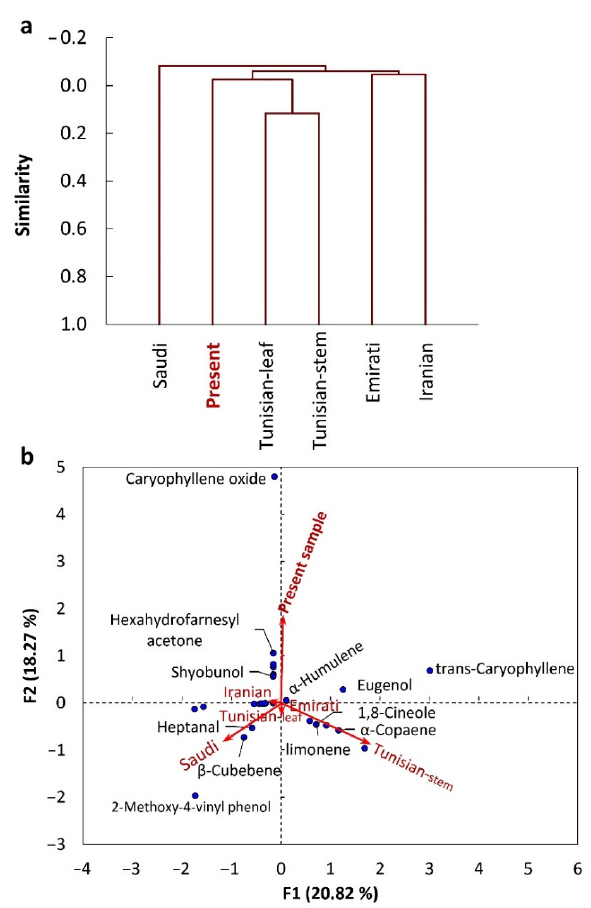
Figure 3. Chemometric analysis of various Cleome amblyocarpa ecospecies. ( a ) agglomerative hierar- chical clustering (AHC), ( b ) and principal components analysis (PCA). ( F1 ) and ( F2 ) are factor 1 and 2.